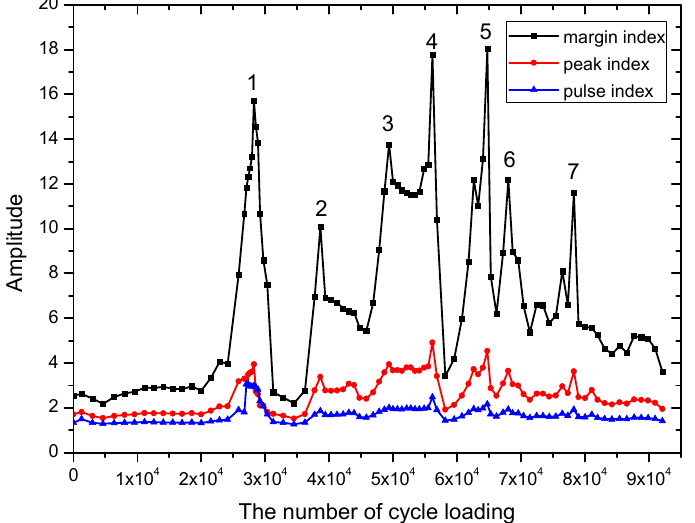
Figure 9. The parameters in the time domain amplitude under different load cycles. Peak value 1, 2, 3, 4, 5, 6, and 7 presented the numbers of the